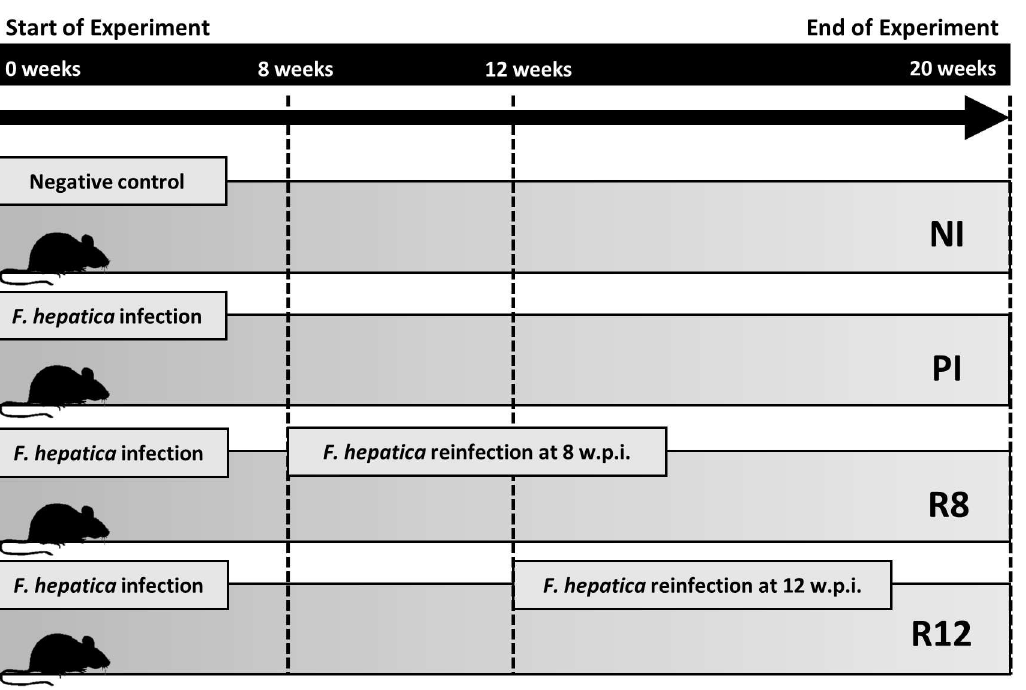
PLOS ONE | https://doi.org/10.1371/journal.pone.0173456 March 31,